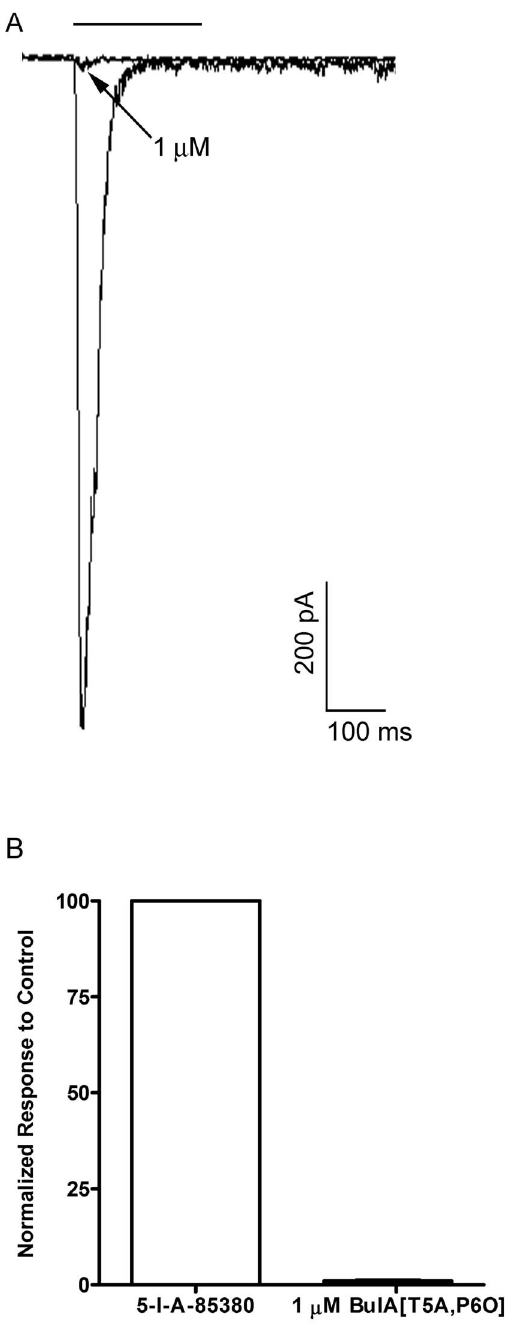
Figure 7. BuIA[T5A,P6O] inhibits 5-I-A-85380-evoked currents in monkey chromaffin cells. A, Representative trace recordings of 5- I-A-85380-evoked currents and the inhibition by 1 m M BuIA[T5A,P6O]. B, Quantitative analysis of the inhibition by 1 m M BuIA[T5A,P6O] (n=4); error bars show average values 6 S.E.M.